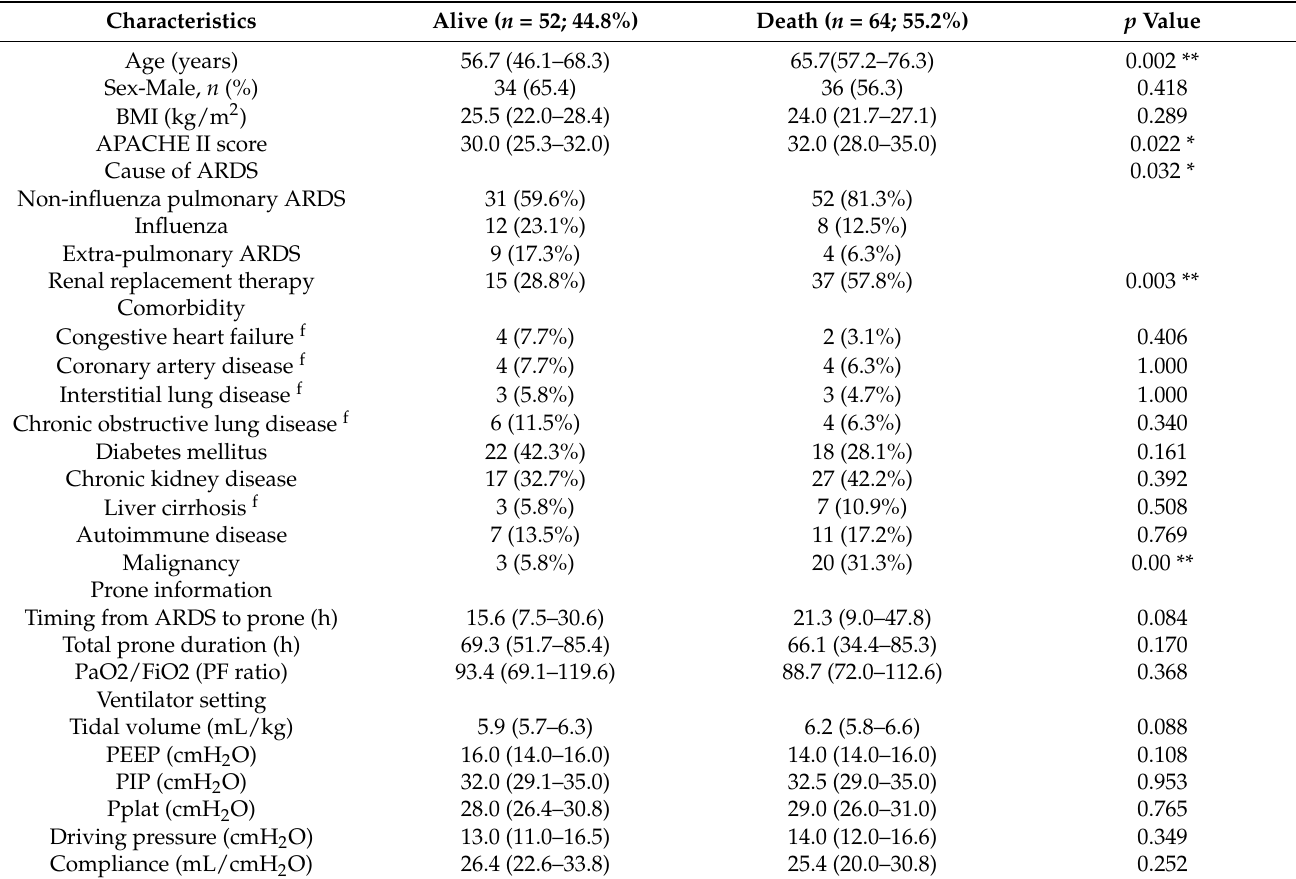
Table 2. Parameters of patients with ARDS receiving prone positioning stratified by survival status. Characteristics